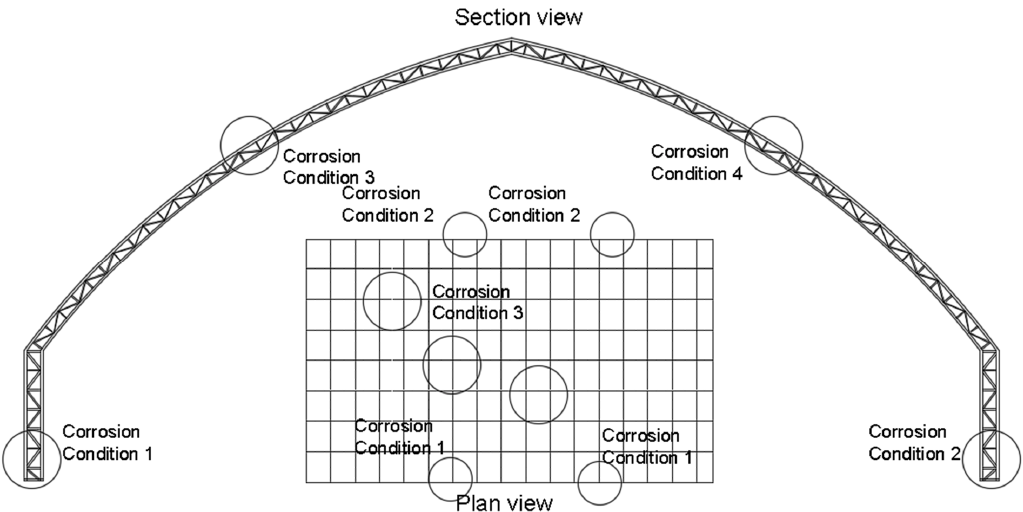
Figure 4. Corrosion conditions of the structures.